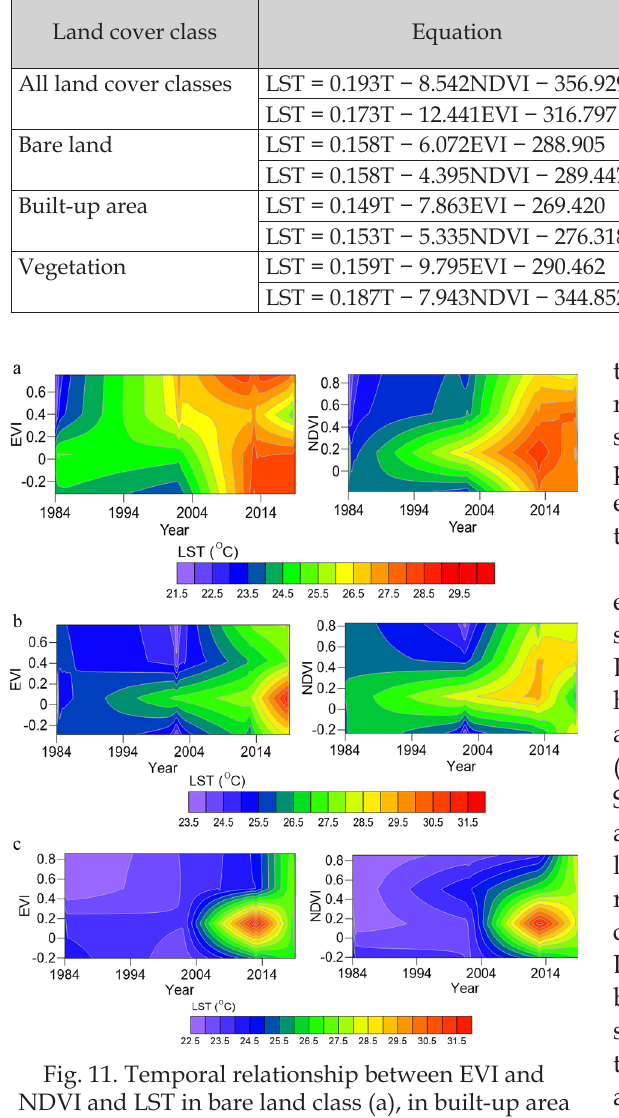
Table 10. Linear regression analysis between the LST, NDVI, EVI and the time period, T. Land cover class